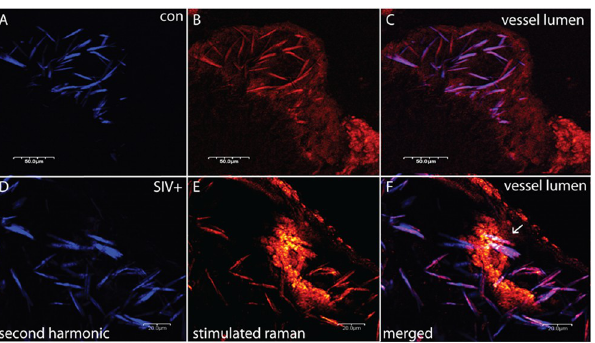
Fig 2. Control and SIV + plaques display needle-like CCs as detected by SRS and SHG imaging. Control plaque, top three panels, SIV + , bottom three, with SHG signal shown in (A & D, blue) SRS signal (B & E, orange) and composites (C & F). Arrow in F points to a macrophage attempting to phagocytose a CC. Scale bars are in micrometers ( μ m), and vessel lumen is denoted.